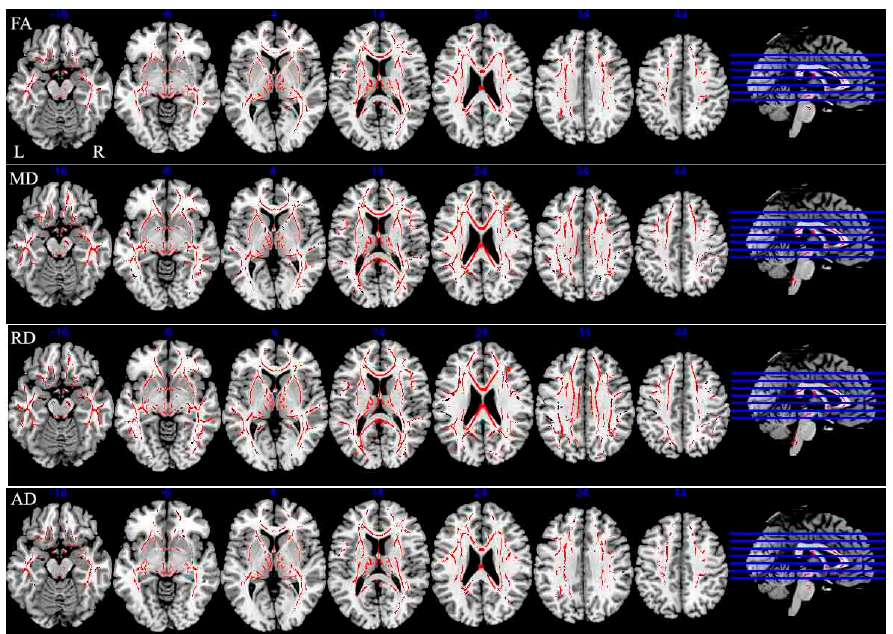
Figure 3. Tract-based spatial statistics (TBSS) analysis results of diffusion metrics images throughout the skeleton in CI patients compared with MS patients with CP. R: right; L: left. Red represents regions with decrease fractional anisotropy (FA), increased mean diffusivity (MD), increased radial diffusivity (RD) and increase axial diffusivity (AD) in CI patients with MS ( p < 0.05, FWE corrected for multiple comparisons). Table 3. WM diffusion changes between CI and CP groups ( p FWE correction <